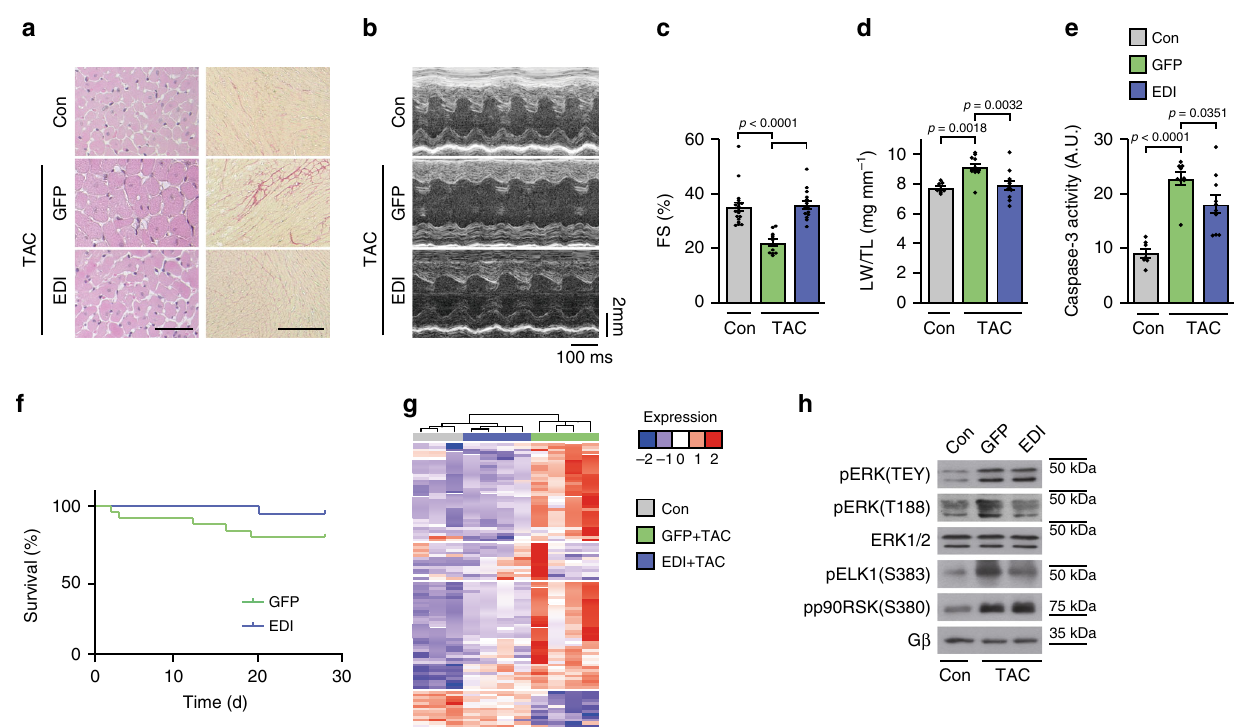
Fig. 4 AAV9-EDI gene therapy protects from pressure overload-induced heart failure. a – h Cardiac characterization of wild-type mice before (Con; 8- week-old C57BL/6 mice) and 4 weeks after transverse aortic constriction (TAC) and treatment with an adeno-associated virus serotype 9 (AAV9) vector encoding the peptide (EDI) or eGFP as a control (GFP) under the control of the CMV-enhanced myosin light chain promotor fragment (CMV-MLC0.26 kb). a Histological analyses: representative H&E (left panel; scale bar 50 µ m) and Sirius Red (right panel; scale bar 200 µ m)-stained pictures of left ventricular myocardial sections, quanti fi cations are shown in Supplementary Table 4. b Representative M-mode echocardiograms. c Echocardiographic fractional shortening (Con, n = 18; GFP + TAC, n = 11; EDI + TAC, n = 14 mice per group). d Lung weight-to-tibia length (LW/TL) ratios (Con, n = 8; GFP + TAC, n = 11; EDI + TAC, n = 11 mice per group). e Caspase-3 activity in heart lysates (Con, n = 7; GFP + TAC, n = 9; EDI + TAC, n = 10). f Kaplan – Meier survival curves of AAV9-eGFP ( n = 24) and AAV9-EDI ( n = 19) treated mice after TAC. g Microarray gene expression analysis of left ventricular myocardial tissue (Con, n = 3; GFP + TAC and EDI + TAC, n = 4 mice per group). Heatmap visualization of the top 100 genes with the highest variance across the samples. For gene list and changes refer to Supplementary Table 6. h Representative immunoblots of heart lysates. Analysis of ERK phosphorylations (pERK[TEY], n = 6; pERK[T188], n = 4) and ERK1/2 target phosphorylation (nuclear pELK[S383], n = 6; cytosolic pp90RSK[S380], n = 8); n numbers represent biologically independent experiments. For quanti fi cation refer to Supplementary Fig. 7C. Error bars are mean ± s.e.m. For statistical analyses ordinary one-way ANOVA and Bonferroni as post hoc test was applied except for f where a survival curve comparison was applied. Source data are provided as a Source Data fi